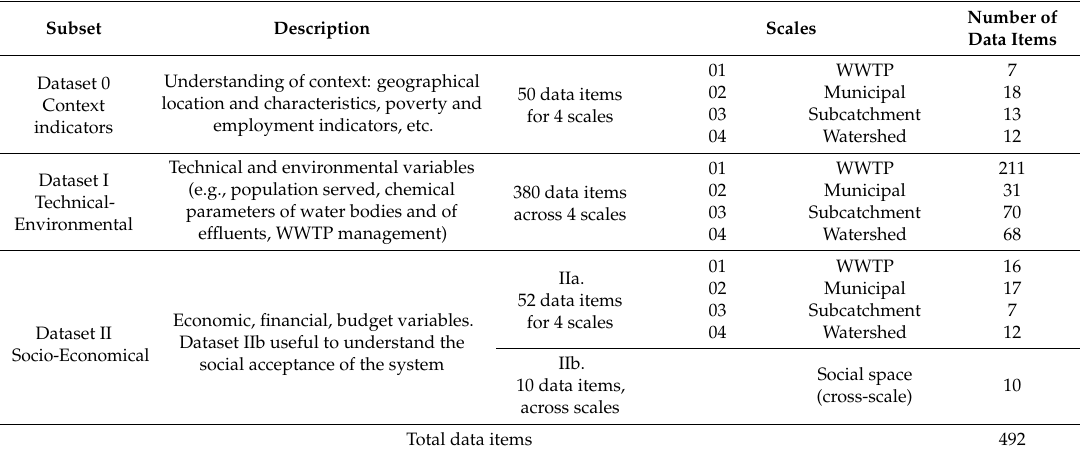
Table 4. Extended dataset framework, overview of subsets and number of data items in each.